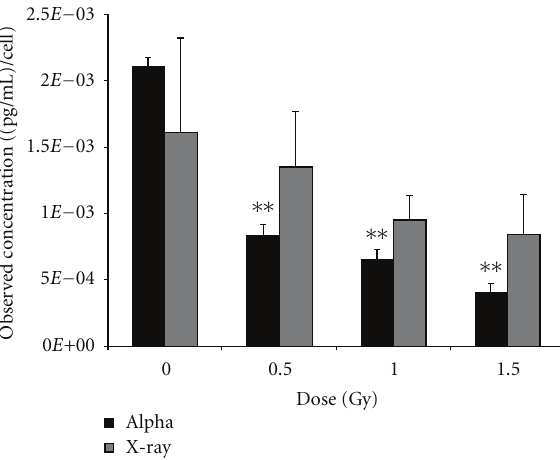
Figure 6: VEGF validation: twenty-four hours after exposure, cell culture supernatants were harvested from A549 cells exposed to 0, 0.5, 1.0, and 1.5 Gy of α -particle radiation and X-irradiation. 25uL of sample was used to determine levels of VEGF secretion using ELISA. ∗ represents P < 0 . 05, ∗∗ represents P < 0 . 01, and ∗∗∗ represents P < 0 . 001, n = 5 biological replicates performed in duplicate. Bars are plotted as cell count corrected means ± SEM.